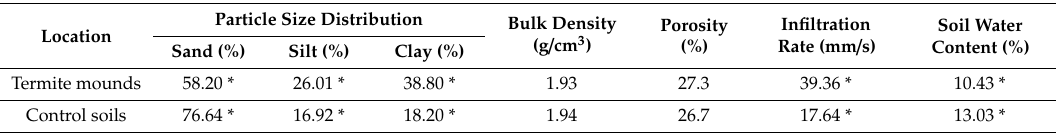
Particle Size Distribution Bulk Density